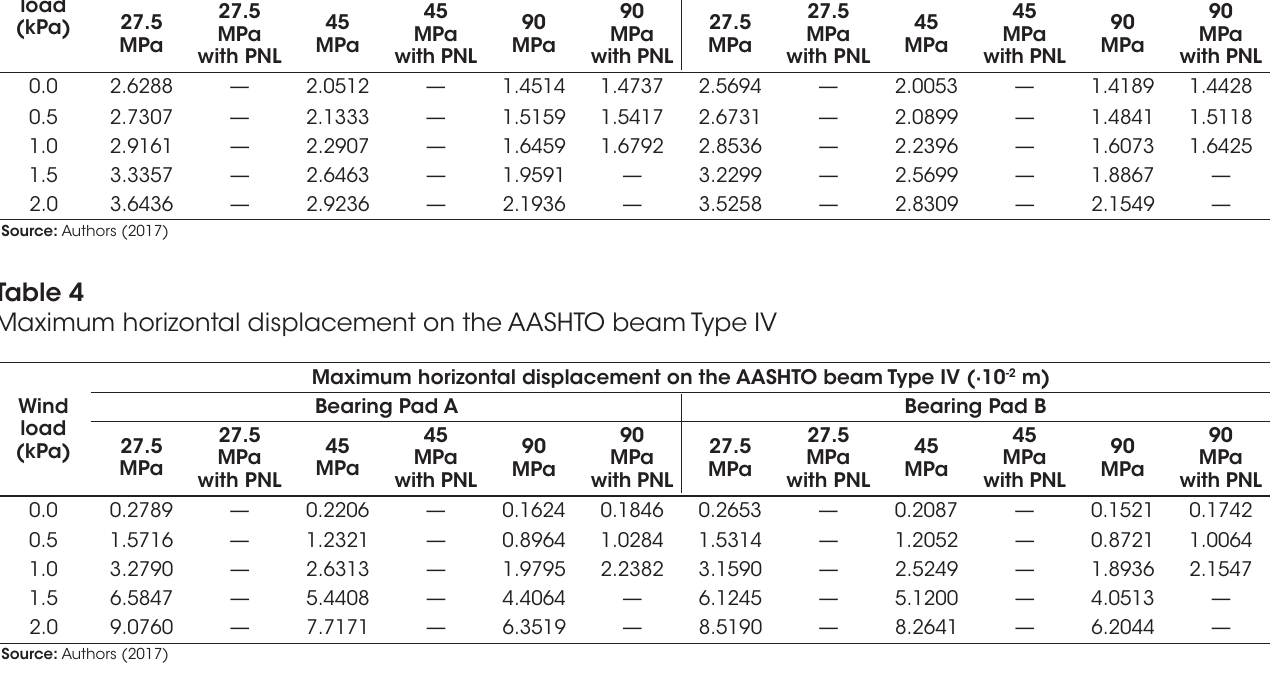
Maximum vertical displacement on the AASHTO beam Type IV Wind